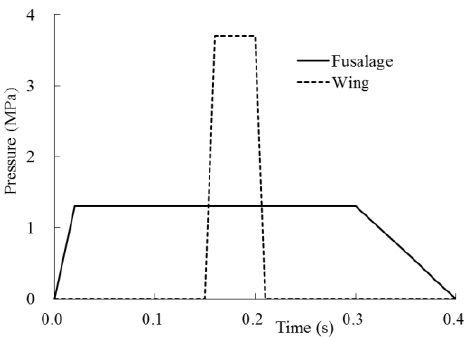
Figure 1. The impact force time-history function of Boeing 747 [22].